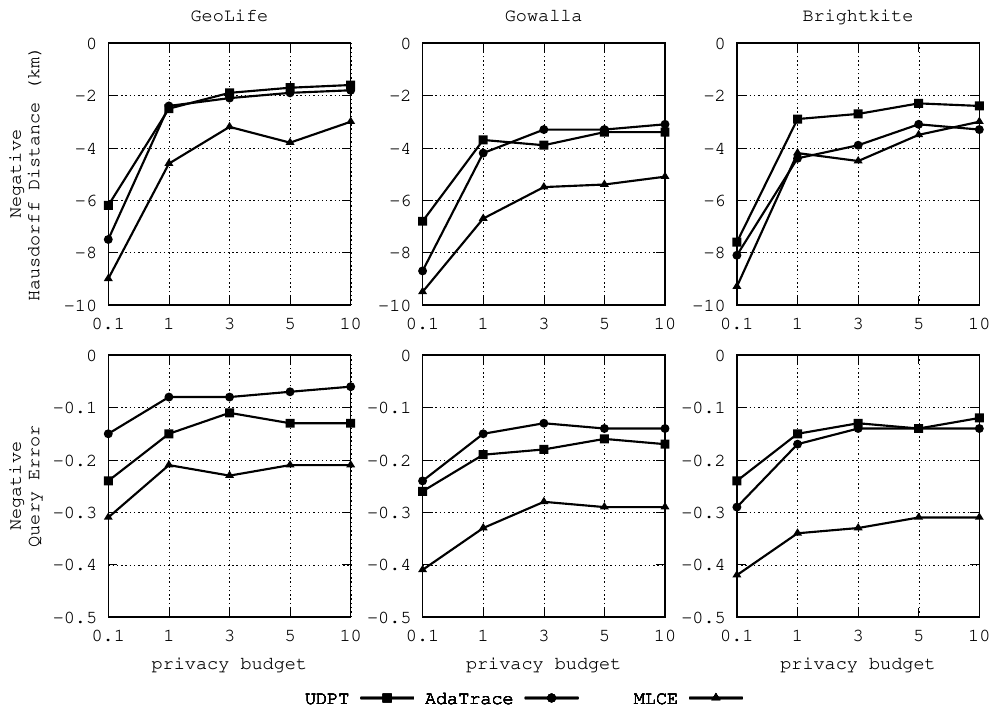
Figure 4. Comparison of UDPT against existing works in terms of geographic utility under different privacy budgets on three datasets. A higher ordinate implies a better utility.